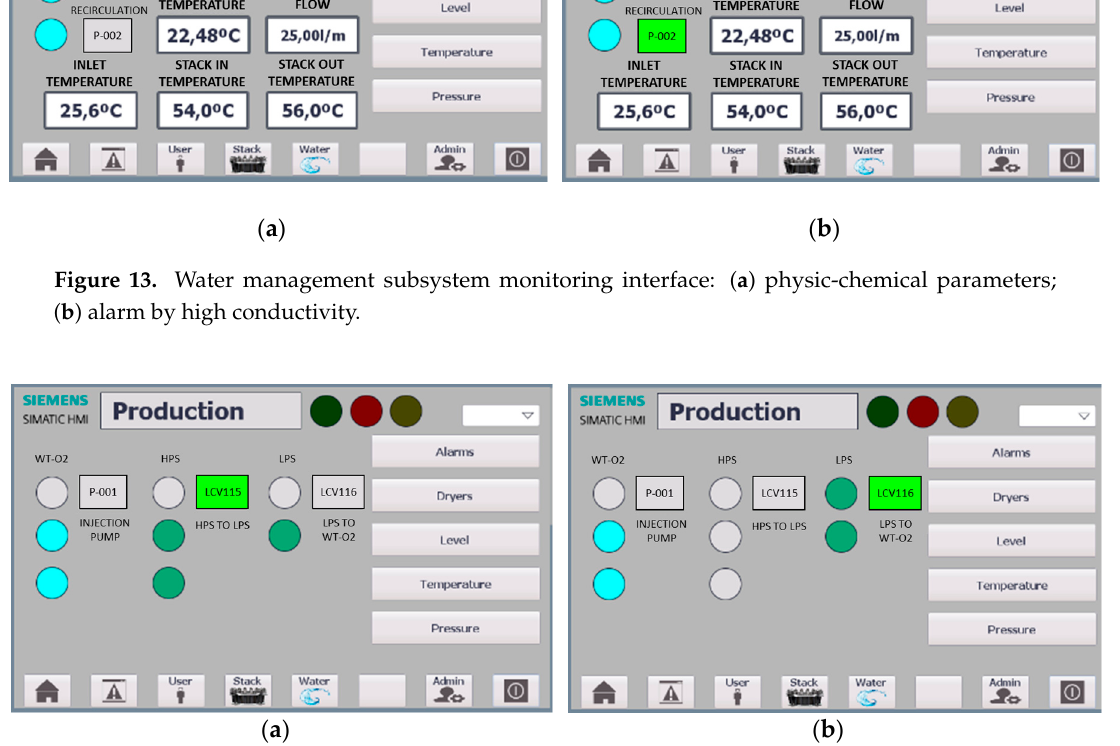
Figure 14. Hydrogen production subsystem monitoring interface: ( a ) mid-level in HPS, valve (LCV115) open; ( b ) high level in LPS, valve (LCV116) open.